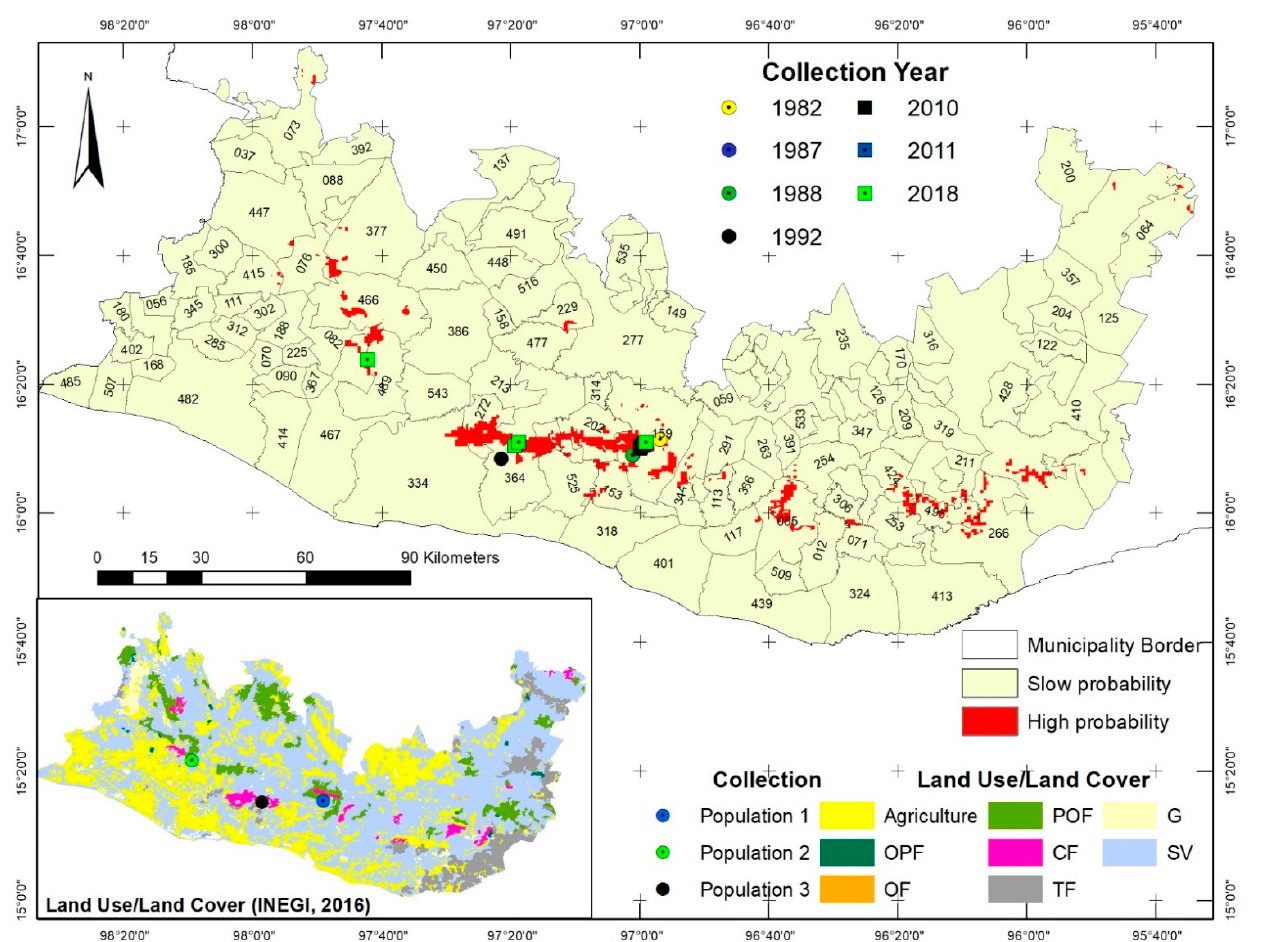
Table 1. Multi-criteria analysis for the potential distribution of Euphorbia fulgens .